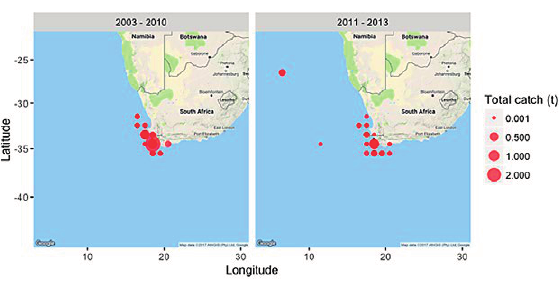
Fig. 5. - Space-time distribution of the total catch by time period off SA.